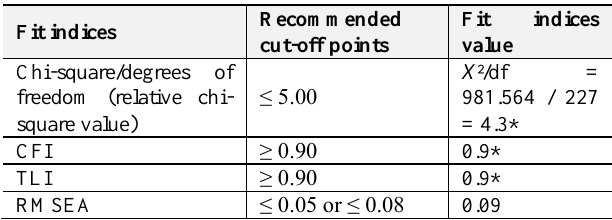
Table 2: Fit indices for the measurement model Fit indices